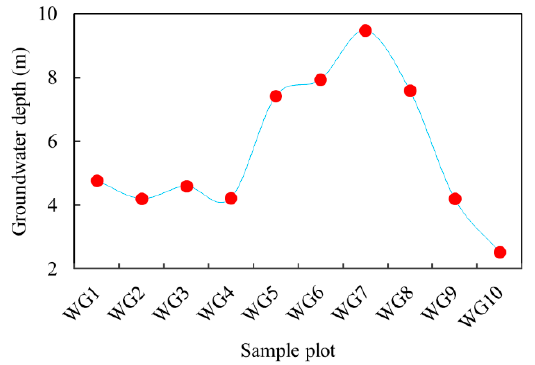
Figure 2. The groundwater level characteristics of 10 monitoring wells.